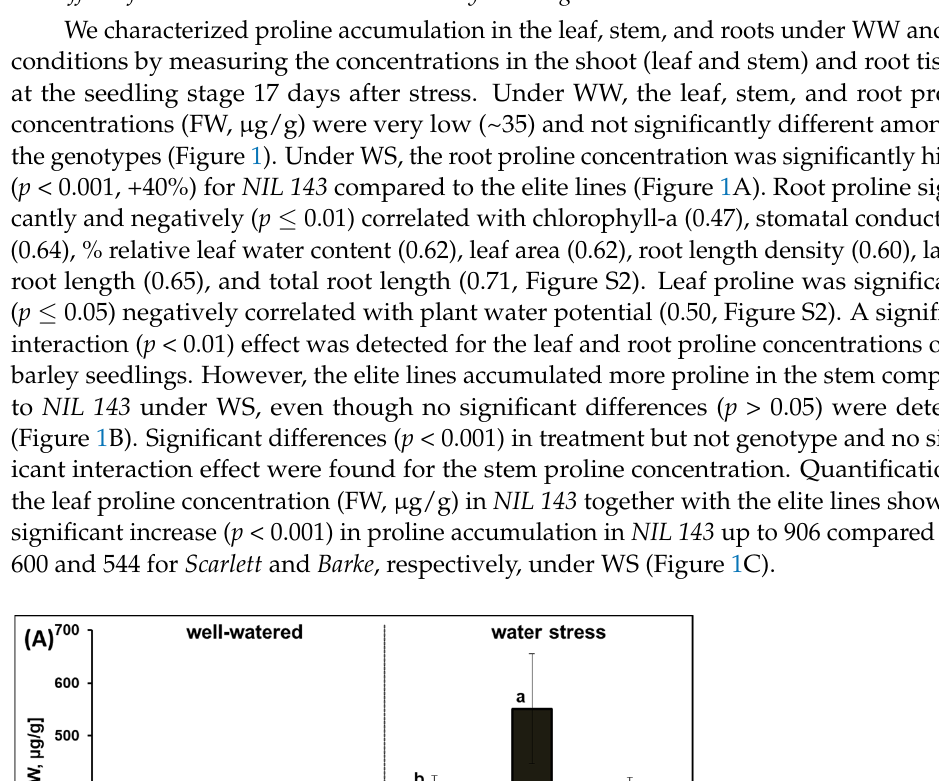
Figure 1. Proline concentration in the root—( A ); stem—( B ); and leaf—( C ) of the barley seedlings 17 days after water stress in rhizoboxes. Significant differences between the genotypes are based on Tukey’s post hoc test ( α = 0.05) indicated with different letters (n = 6).